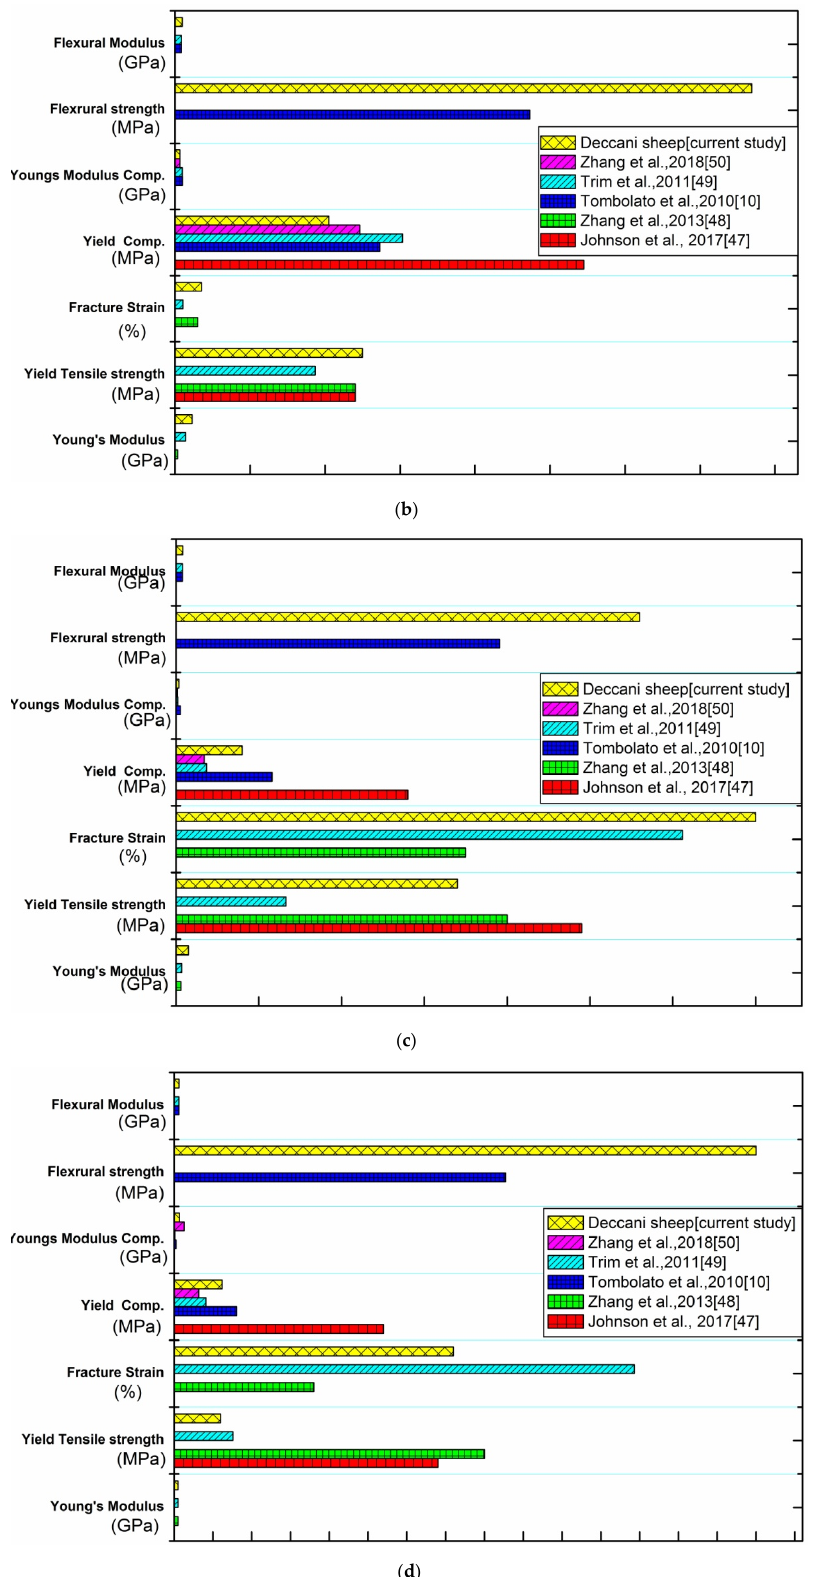
Figure 13. Comparison of mechanical properties with previous results at ( a ) longitudinal dry conditions (SLD), ( b ) transverse dry conditions (SLD), ( c ) longitudinal wet conditions (SLW), and ( d ) transverse wet conditions (STW).